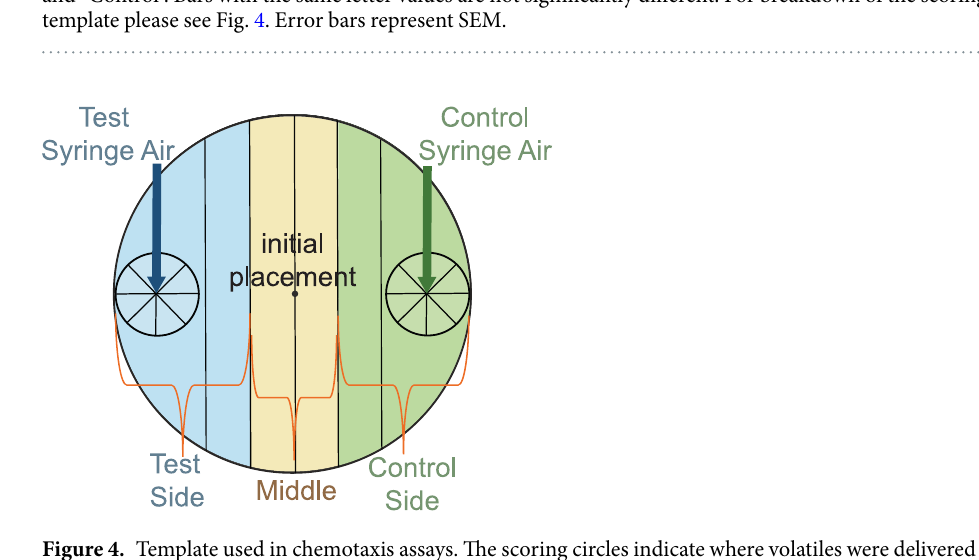
Figure 4. Template used in chemotaxis assays. The scoring circles indicate where volatiles were delivered (for insect-odor response assays) or where odorants were applied (for chemical response assays). Scoring circles were used to count nematodes and calculate chemotaxis indices (CI values), while the 3 designated sides (test, middle and control) were used to determine